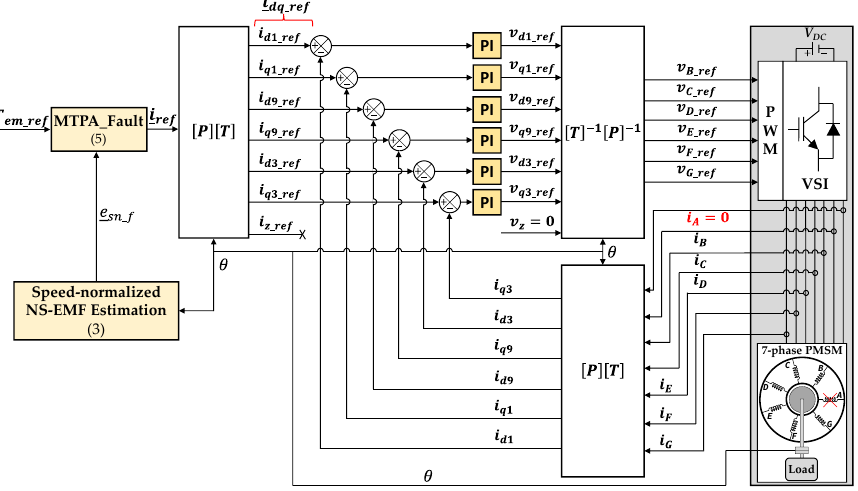
Figure 1. Torque control with the conventional RFOC scheme using MTPA_Fault for a seven-phase PMSM when phase A is opened.